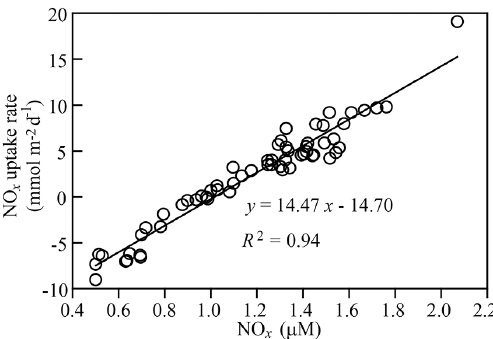
Figure 11. Uptake rate of NO x against the concentration of NO x in the water column at reef station CT in a spring–neap tide during 6–13 February